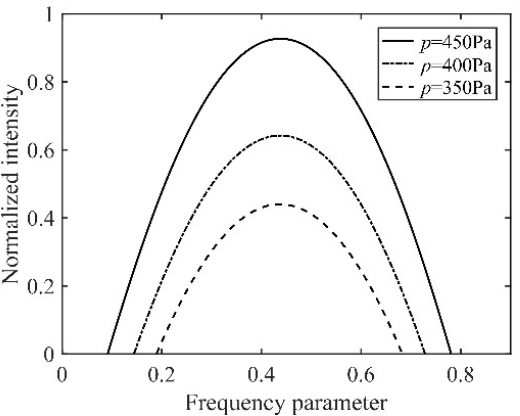
Figure 5. Ne 20 :Ne 22 = 1:1, with inflation pressures of 350 Pa, 400 Pa and 450 Pa; the normalized results of the intensity tuning curve in the ring laser gyro.